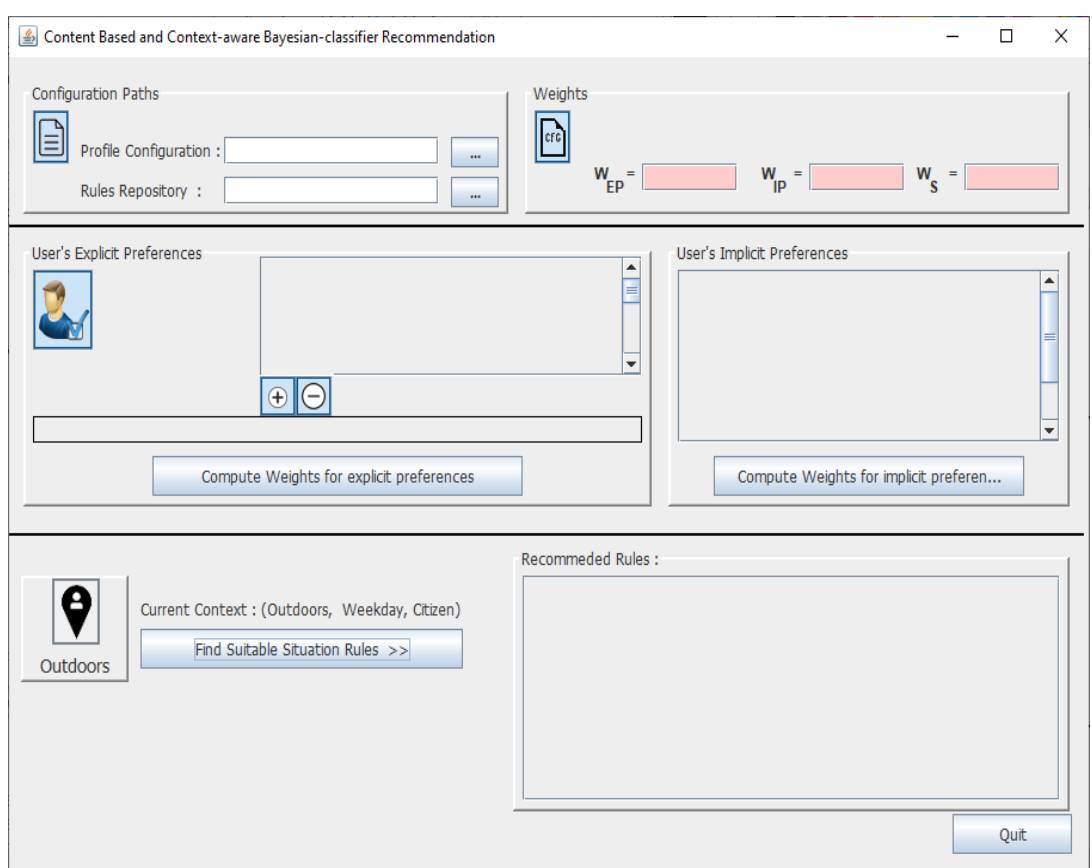
Figure 5. Main GUI of our recommendation and adaptation approach.